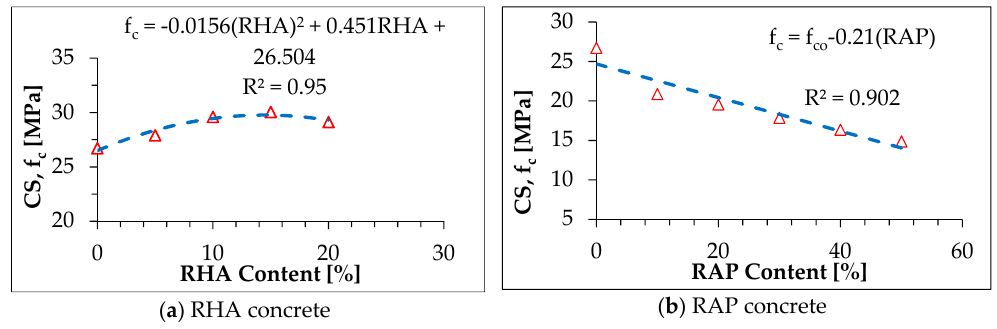
Figure 9. Relationship between RHA and RAP content and CS.